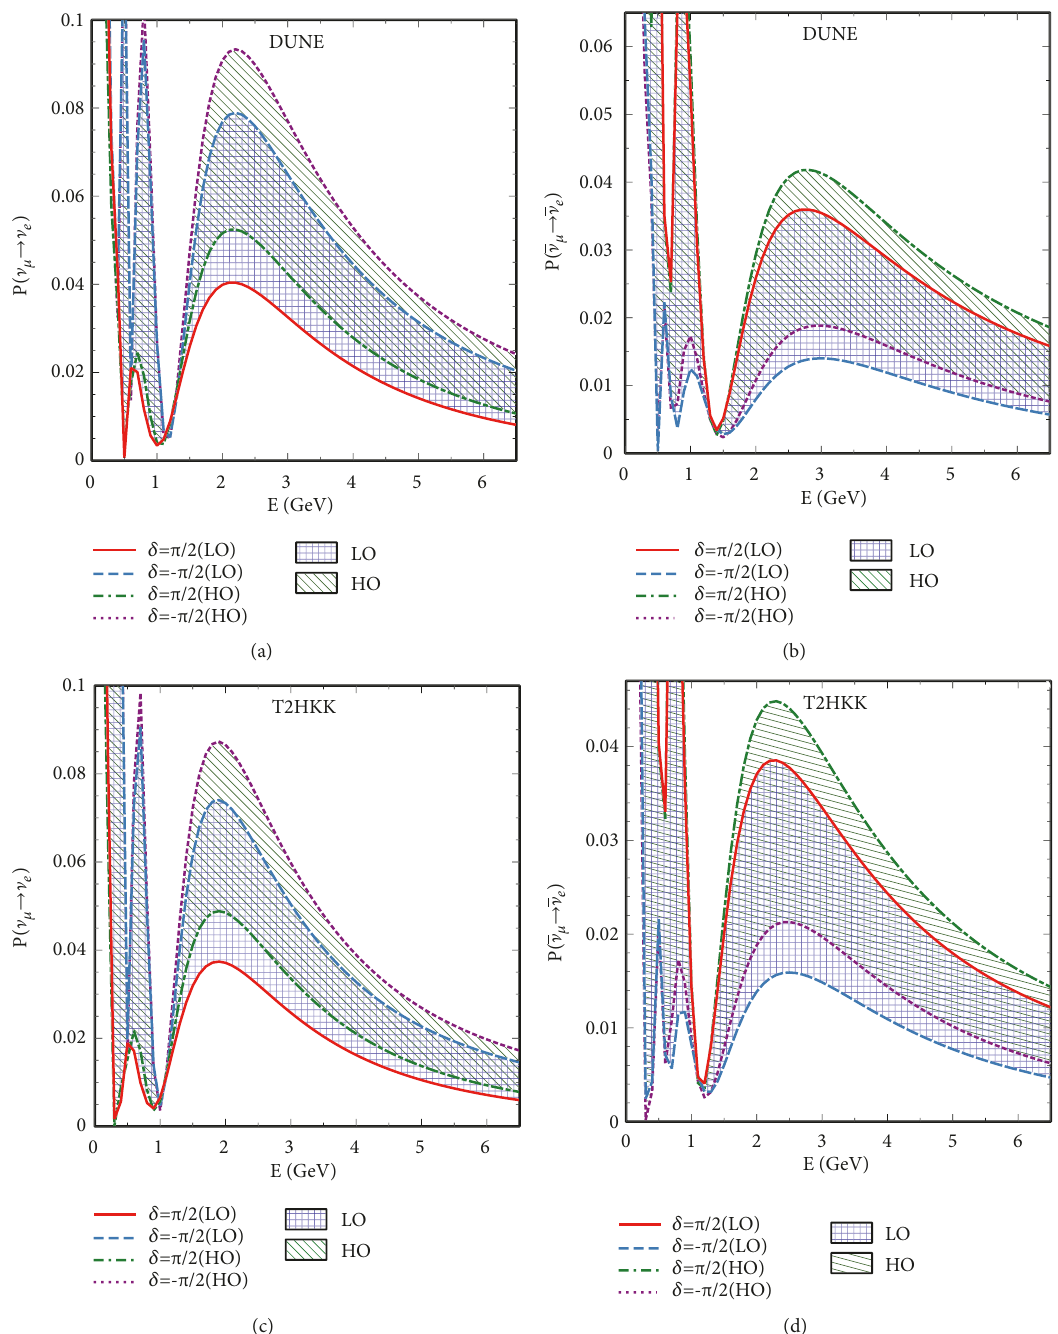
Figure 4: The appearance probability for neutrino (antineutrino) mode as function of neutrino beam energy 𝐸 for DUNE (first row) and T2HKK (second row) assuming NSI parameters 𝜖 푒휇 = 0.04 and 𝛿 푒휇 = [−𝜋,𝜋] . The octant degeneracy is represented for neutrino mode (left panel) and for antineutrino mode (right panel). The band comes due to variation of 𝛿,𝛿 푒휇 ∈ [−𝜋,𝜋] and the boundaries of the bands correspond to 𝛿 = ±𝜋/2 for LO and HO. The value of 𝜃 23 = 42 ∘ for LO and 𝜃 23 = 48 ∘ for HO.